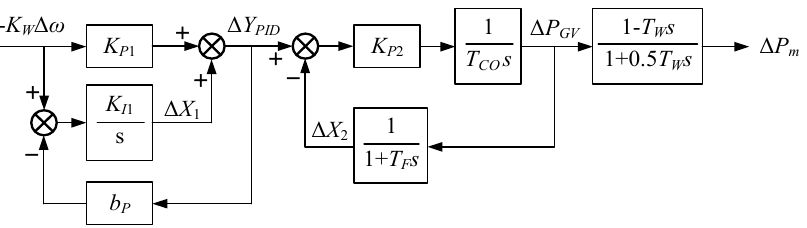
Figure 7. Block diagram of a water turbine and a PID governor. Symbols: K W , the gain of frequency deviation; b p , permanent difference coefficient; K P 1 , the gain of the governor; K I 1 , the integral gain of the governor; K P 2 , the gain of the servo system; T F , the time constant of stroke feedback; T W , the time constant of the water hammer.